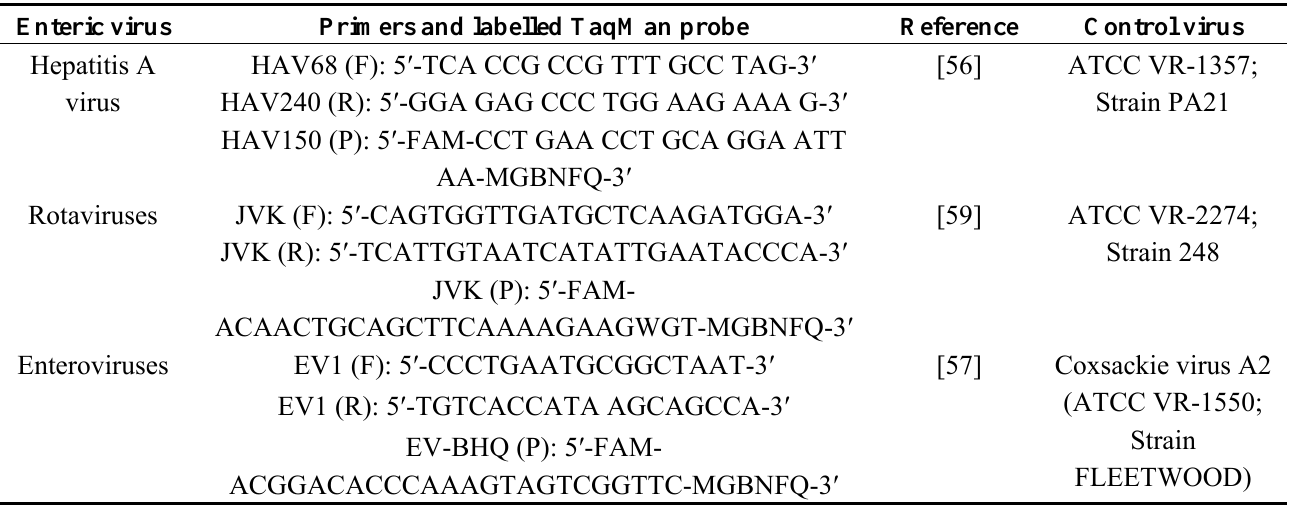
Table 1. Primers, probes, and control viruses used for the real-time